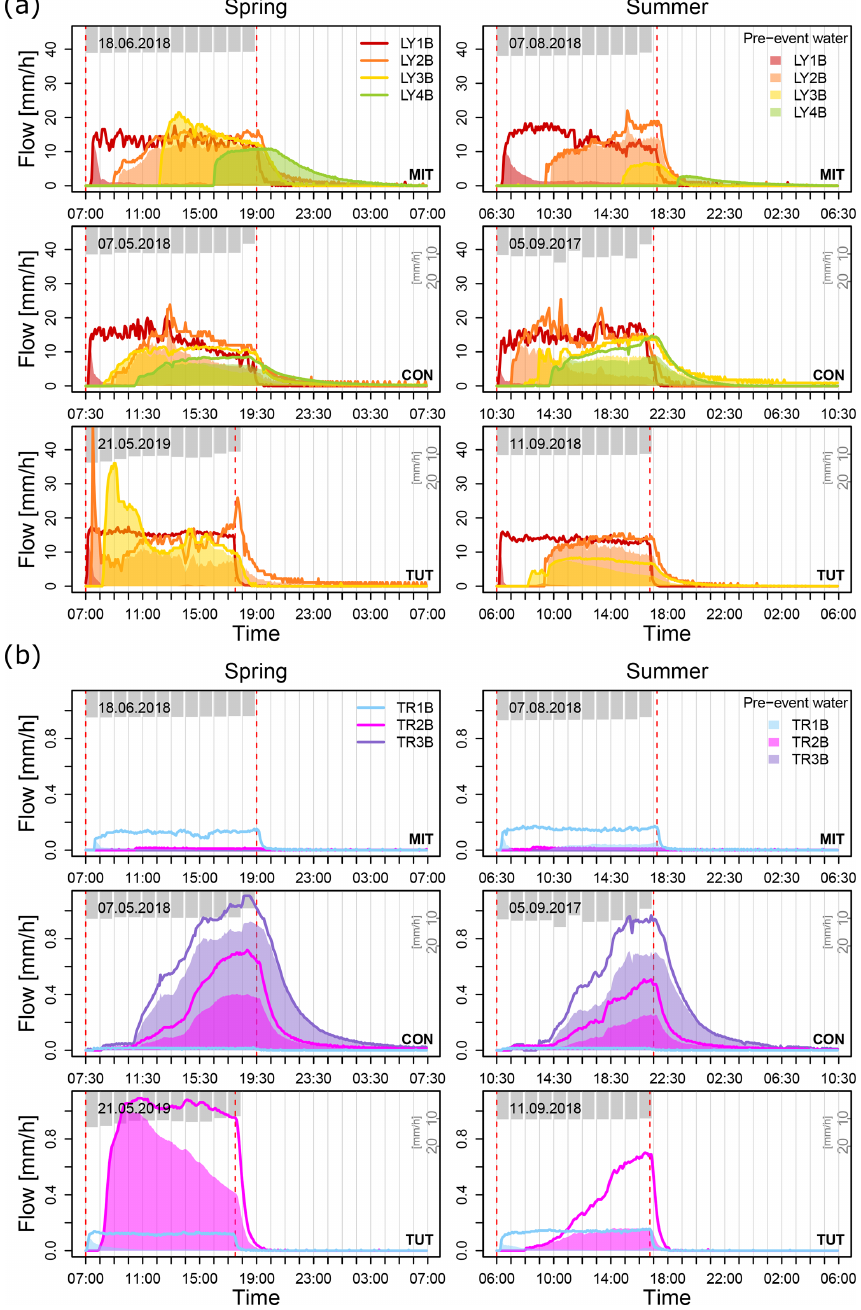
Figure 3. (a) Vertical subsurface flow from the lysimeters (LY1B, LY2B, LY3B, LY4B) and (b) lateral subsurface flow from the trench (TR1B, TR2B, TR3B) for the sprinkling experiments in Mitterfels (MIT), Conventwald (CON) and Tuttlingen (TUT) sorted in rows for spring (left column) and summer (right column). Color-shaded areas show the pre-event water contribution to total discharge of each component (calculated from the deuterium tracer). Dashed red lines indicate the start and end of the sprinkling experiment. Gray bars show sprinkling input during the